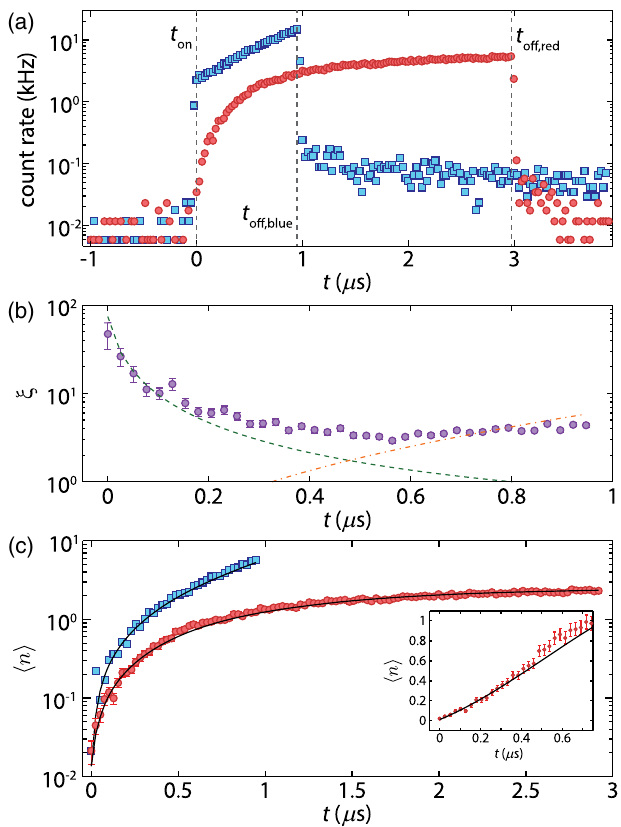
FIG. 2. (a) Total photon-count rate versus time t for a red- detuned (red circles, Δ ¼ ω ) and blue-detuned (blue squares, m Δ ¼ − ω ≈ 45 and T ¼ 5 ms. ) probe. For both data sets, n m c; on per Vertical dashed lines indicate the start and stop times of the pulses. (b) Asymmetry ξ versus time within the pulse t . The dashed green line shows the theoretically expected ξ ð t Þ when backaction effects are neglected and a single time-dependent phonon occupancy is assumed for both detunings. The dash- dotted orange line shows ξ ð t Þ , including the effects of back- action, neglecting optical heating and assuming ξ ð 0 Þ ¼ 0 . Error bars show one standard deviation (s.d.) determined from the measured count rates, assuming Poissonian counting statistics. (c) Calibrated phonon occupancy h n i versus t for Δ ¼ ω (red m circles) and Δ ¼ − ω (blue squares). The solid black lines show m fits to a model including a slow exponential turn-on of the hot- phonon bath. The inset shows detail for 0 < t < 750 ns on a linear scale for Δ ¼ ω . Error bars show one s.d. determined m from the measured count rates, assuming Poissonian counting statistics. For the blue-detuned data, the error bars are smaller than the data